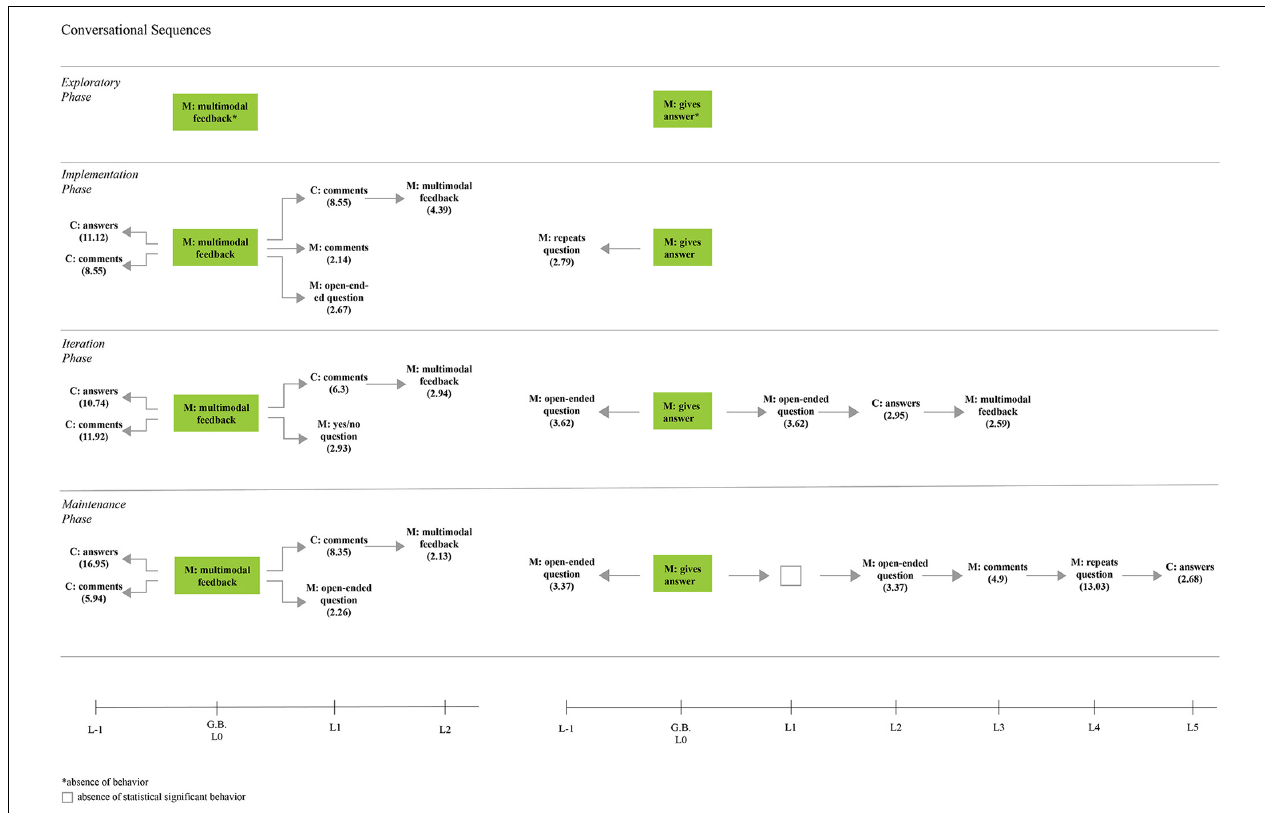
FIGURE 7 | Sequential communicative patterns obtain in each phase during the storybook reading with the mother’s providing feedback and answers as given behavior [M, Mother; C, Child].